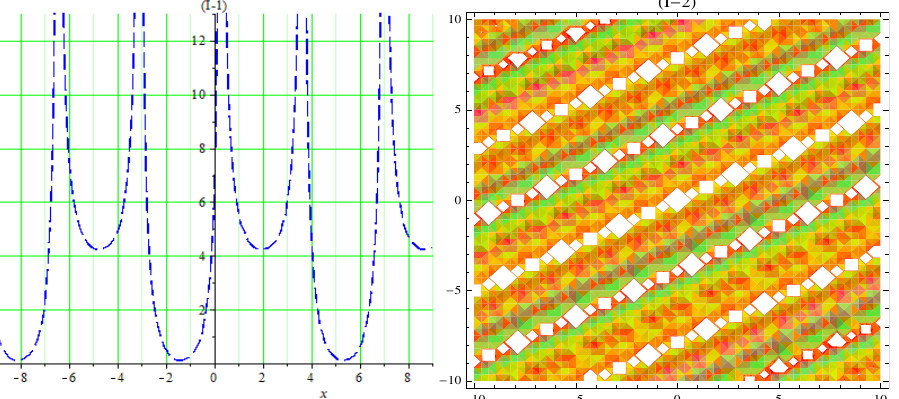
Figure 9. ( I ) 3D graph of periodic–singular soliton of (62) with l = 0.8, m = 0.3, µ = 0.2, A = 2.6, ζ = 0.65, V = 0.5, λ = 0.55. ( I-1 ) 2D plot and ( I-2 ) contour plot of